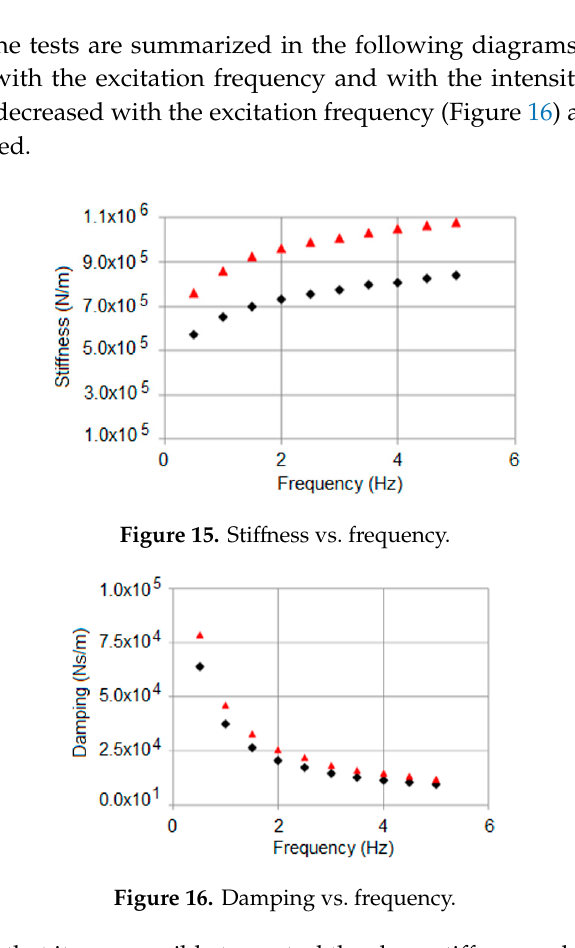
Figure 14. Shear tests: ( a ) f = 5 Hz; and ( b ) f = 10 Hz.